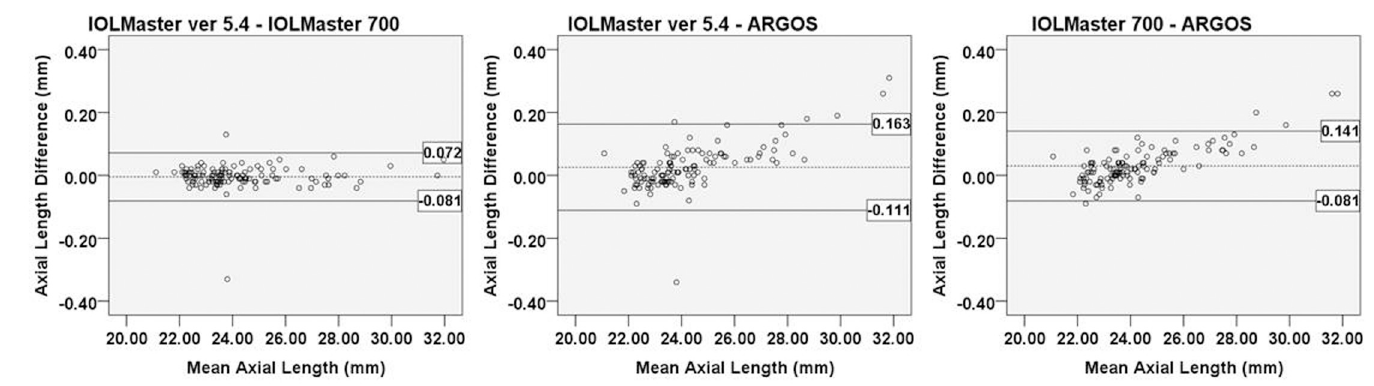
Fig 1. Bland-Altman plot of axial length measurements for each device. The mean difference is indicated by the dashed lines, and 95% LoA is indicated by the solid line. Comparison of IOLMaster ver. 5.4 and IOLMaster 700 (A); IOLMaster ver. 5.4 and Argos (B); and IOLMaster 700 and Argos (C).